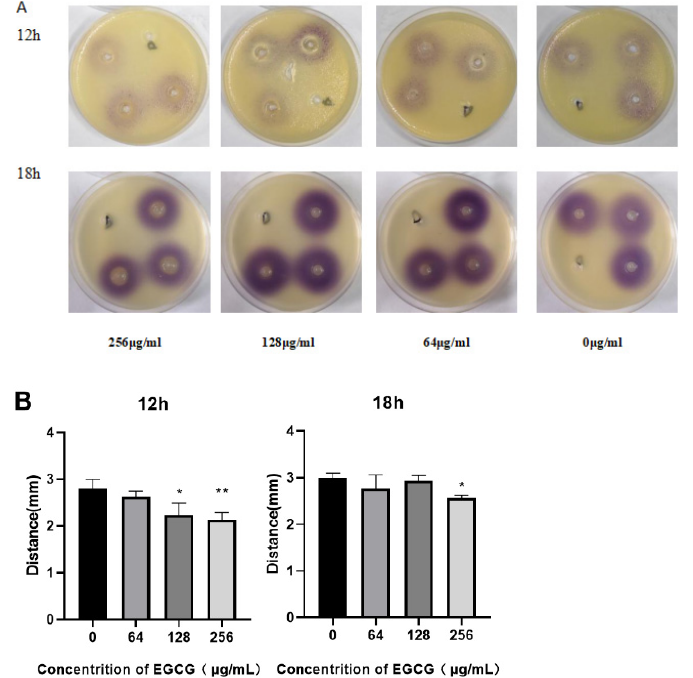
Figure 9. Effect of EGCG on the production of signaling molecules C4-AHL with the C. violaceum CV026. ( A ). Using LB agar with well diffusion assay to detect signaling molecules C4-AHL. ( B ). The diffusion distance of violacein at 12 h and 18 h. (All data are representative of three independent experiments performed in triplicate and expressed as the mean ± SD values in each bar. * p < 0.05; ** p < 0.01.